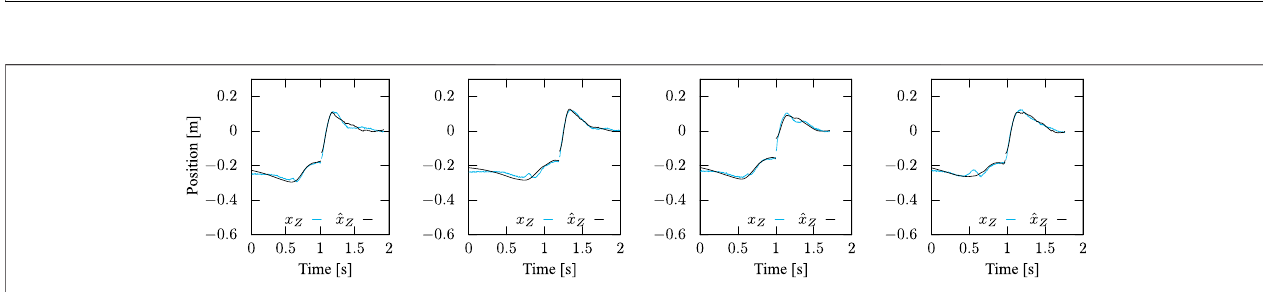
FIGURE13| Measuredandidenti fi edZMPtrajectoriesbasedon Eq.16 ,inwhichtheinertialtorqueaboutCOMistakenintoaccount.Stepstridewascontrolledto be 45 cm. The latter reproduced the former well in both the stepping and braking phases.